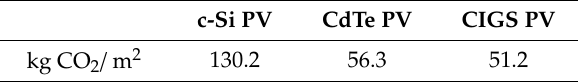
Table 2. The GWP of 1 m 2 of commercial PV modules